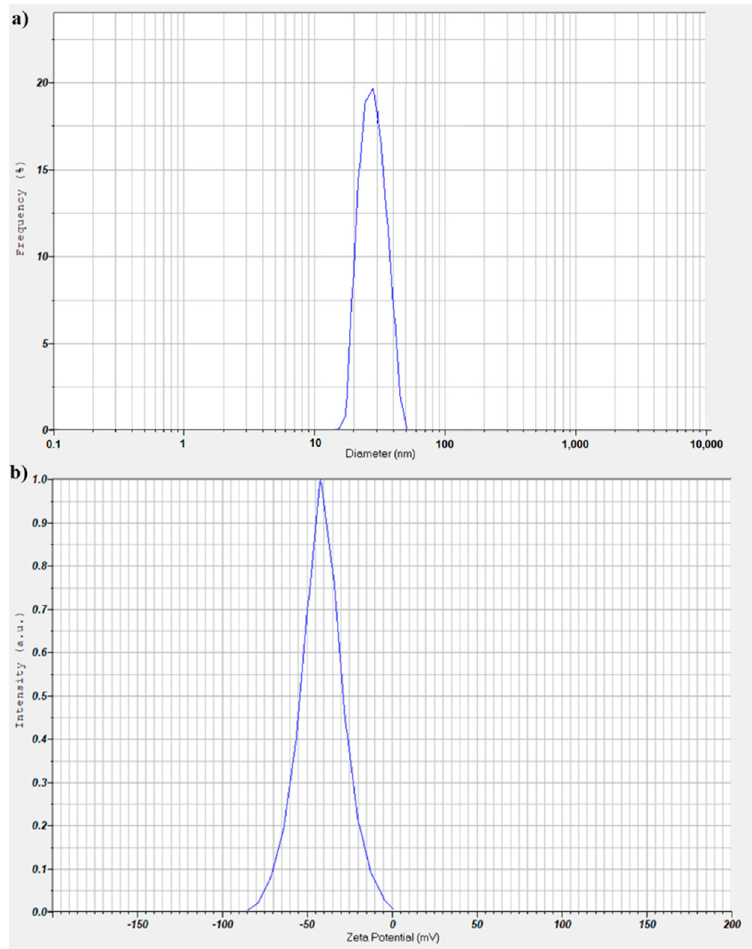
Figure 5. Particle size distribution ( a ) from DLS measurement and ζ -potential curves ( b ) of the dextran-coated iron oxide nanoparticle (D-MNP) suspensions.